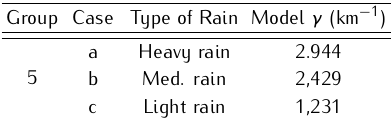
Table 18. Calculated extinction coefficients for rain.